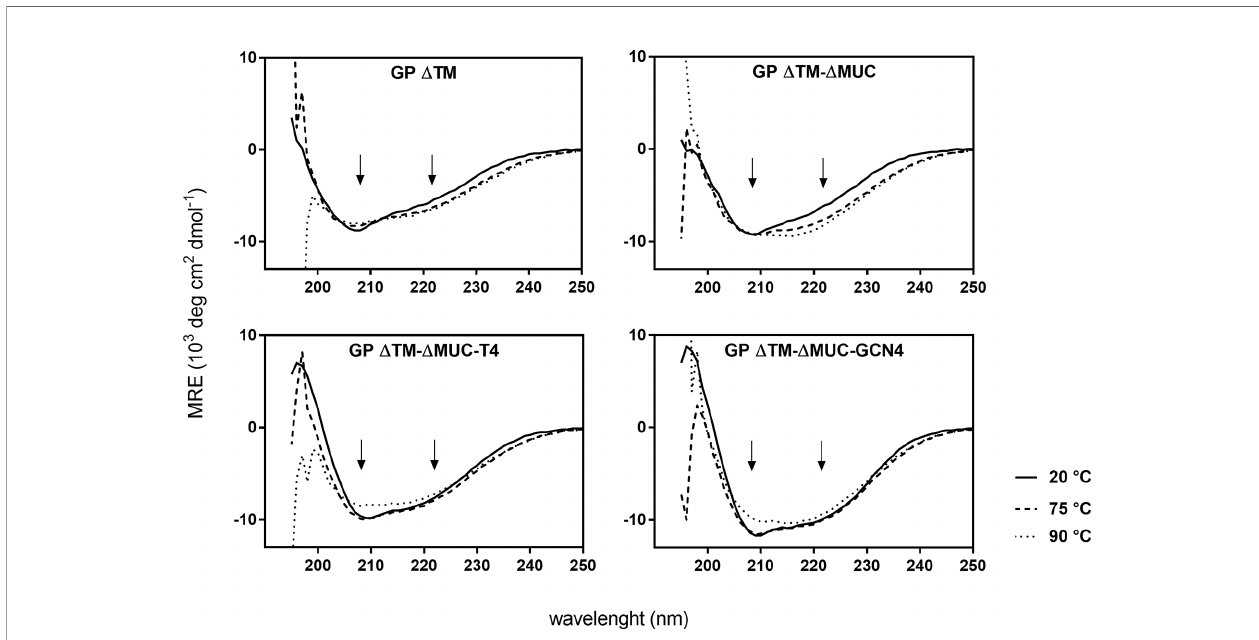
FIGURE 3 | The insertion of a C-terminal trimerization motif favors the formation of the a -helical bundle and enhances the thermal stability of the recombinant GP. Temperature dependent CD spectra of GP D TM, GP D TM- D MUC, GP D TM- D MUC-T4, and GP D TM- D MUC-GCN4. Spectra were registered between 190 and 250 nm and between 20°C and 90°C at 5°C interval. For clarity, only spectra at 20°C, 75°C, and 90°C are shown. The arrows indicate the double minima at 208 and 222 nm, spectral signature typical of an a -helical secondary structure.